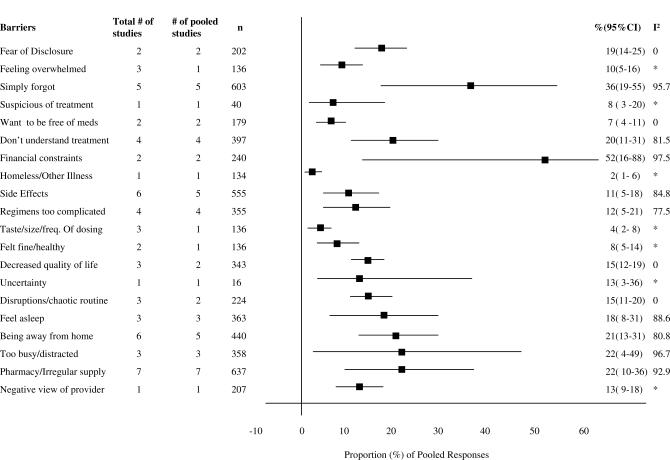
Barriers Reported in Developing Countries